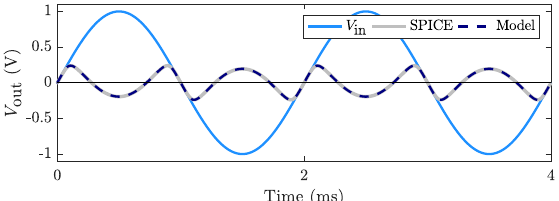
Figure 8. Time-domain view of the Serge wavefolder model plotted against its SPICE simulation for a 500-Hz sinusoidal input with peak amplitude if 1V.